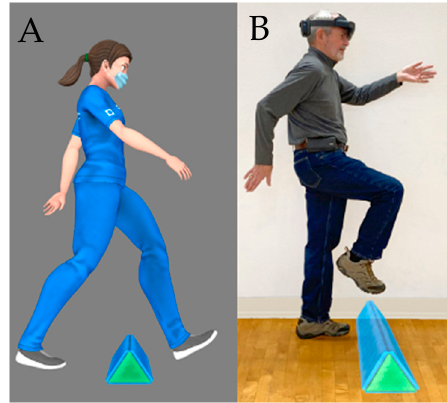
Figure 3. ( A ) Donna, the digital DART avatar, demonstrating stepping over an object during the obstacle course instructions. ( B ). An individual with PD navigating the same object in the obstacle course. The object on the floor is a hologram only visible to the user wearing the HL2.